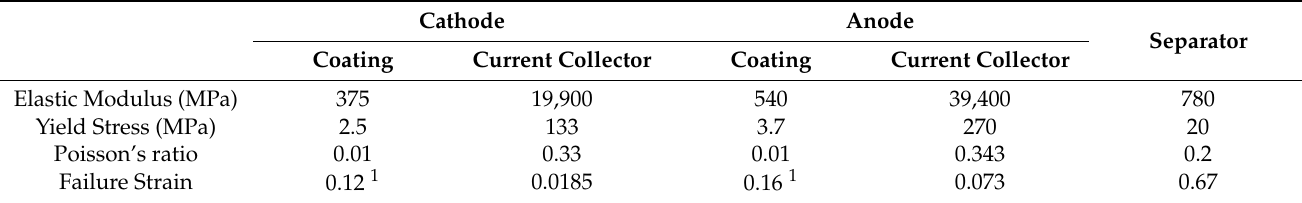
Figure 6. Tensile model fitting stress-strain curves: ( a ) Cathode/Cathode current collector/Cathode active coating; ( b ) Anode/Anode current collector/Anode active coating; ( c ) Separator; Compressive model fitting stress-strain curves: ( d ) Cathode/Cathode current collector/Cathode active coating; ( e ) Anode/Anode current collector/Anode active coating; ( f ) Separator. Table 2. Tensile properties of lithium-ion prismatic cell